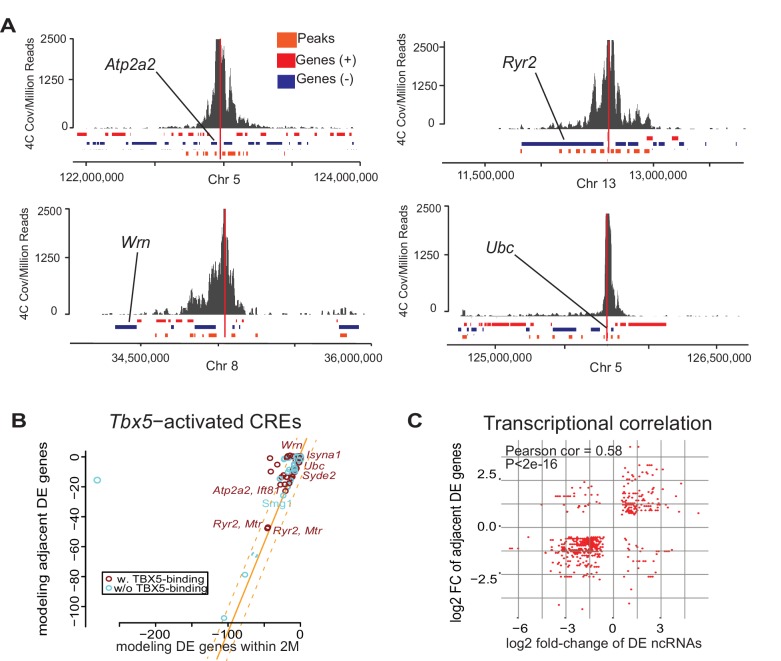
Enhancer transcription mediates target gene expression.(A) Genomic loci showing circularized chromatin conformation capture (4C) from the viewpoint of four identified regulatory elements (near Atp2a2, Wrn, Ryr2, and Ubc). Total reads (top) and significant contacts (bottom, orange) are plotted. Annotated genes are shown in blue and red (sense and antisense, respectively). The viewpoint is with a dashed red line and the nearest TBX5-dependent target is labeled. (B) Sparse scatterplot for combined Pi-scores calculated from Tbx5-activated enhancers and Tbx5-activated genes. The X-axis is the pi-score using the ‘nearest’ Tbx5-dependent gene, and the Y-axis is the pi-score using all potential TF-dependent gene targets within a 2-Mbp window. The orange line indicates y = x. The dashed lines mark the standard deviations. Example enhancers were labeled with the names of their nearest Tbx5-dependent gene. Red indicates enhancers with TBX5 occupancy, and blue indicates enhancers without TBX5 occupancy as determined by ChIP-seq. (C) Scatterplot in hexagonal binning for the 3067 identified TF-dependent ncRNAs. The X-axis is the differential expression fold change on a log2 scale of these ncRNAs, and the Y-axis is the differential expression fold change on log2 scale of any nearest gene targets. The fold change with the maximum absolute value is used when both neighbor genes are TF-dependent.